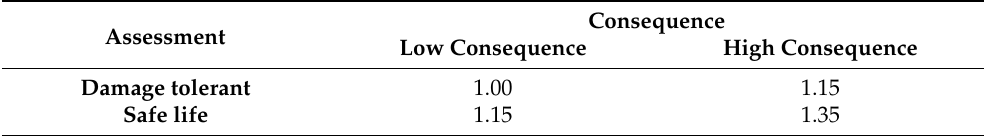
Figure 8. Table 8.8 UNI EN 1993-1-9—Construction details of closed rib in orthotropic plates (2/2) [53]. Table 2. Partial safety factor for fatigue